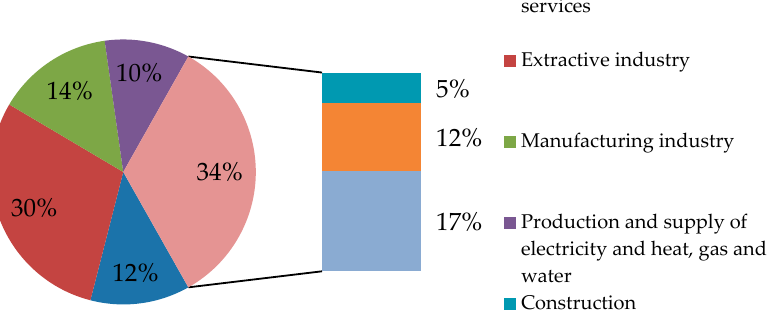
Figure 1. Distribution of the questioned entities by activity areas.